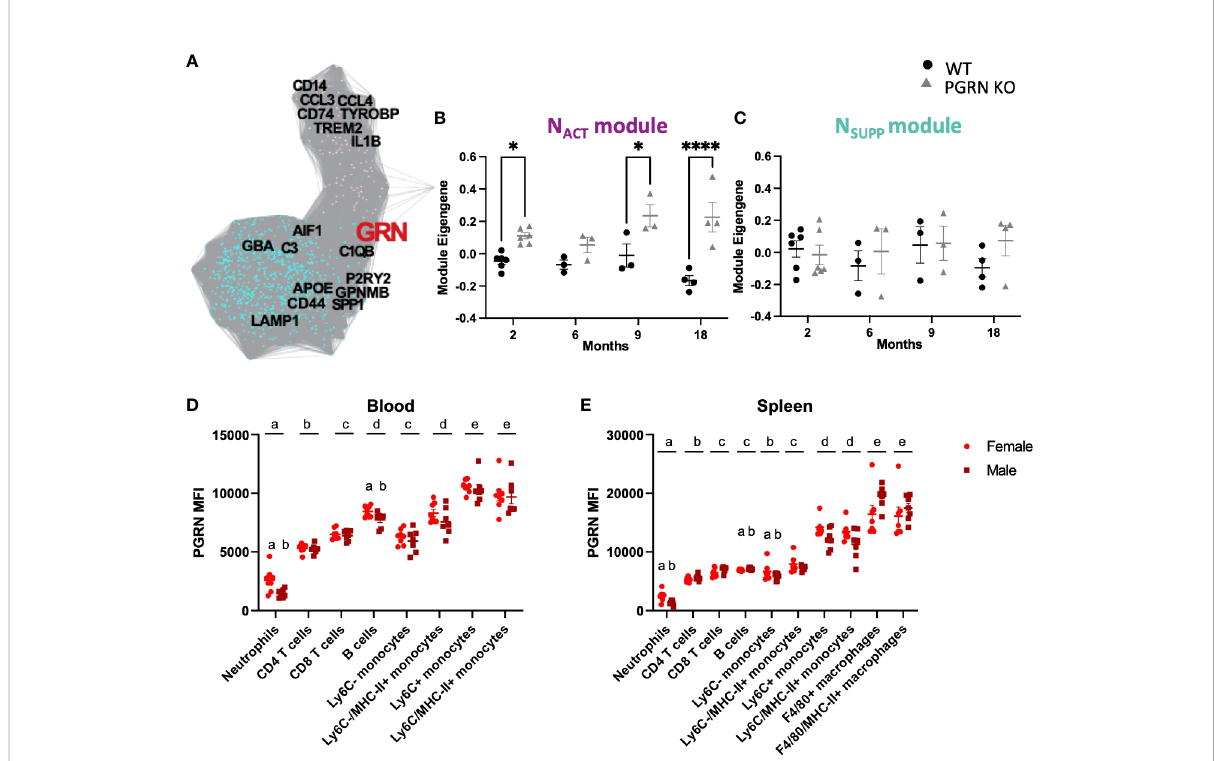
FIGURE 1 PGRN regulates in fl ammatory responses in the periphery and central nervous system. (A) Gene co-expression adjacency network plot showing GRN is in the N SUPP module (turquoise) and highly connected to N ACT (pink) module, with genes as nodes and edges between genes proportional to their bi-weighted miscorrelation of their expression in MAPT mutant microglia (see Methods). (B) Module eigengene trajectory of N ACT in PGRN knockout, and WT cerebral cortex from Lui et al. (17) (n= 3-6 per condition, two way ANOVA genotype effect p < 0.0001 and interaction p = 0.039, Bonferroni post hoc) . (C) Module eigengene trajectory of N SUPP in PGRN knockout, and WT cerebral cortex from Lui et al. (17) (n= 3-6 per condition, Mann-Whitney with Holm-S ̌ ida ́ k post-hoc ). (D) PBMCs and (E) splenocytes from 18 – 21-month-old female and male B6 mice were isolated, and different immune cell subsets were assessed for PGRN MFI determined by fl ow cytometry, n= 6 per sex; two-way ANOVA, cell type and sex effect p < 0.05 for all, Bonferroni post hoc . Letter(s) centered above groups re fl ect results of post hoc tests. Groups that do not share any letters are signi fi cantly different from one another. *p<0.05 and ****